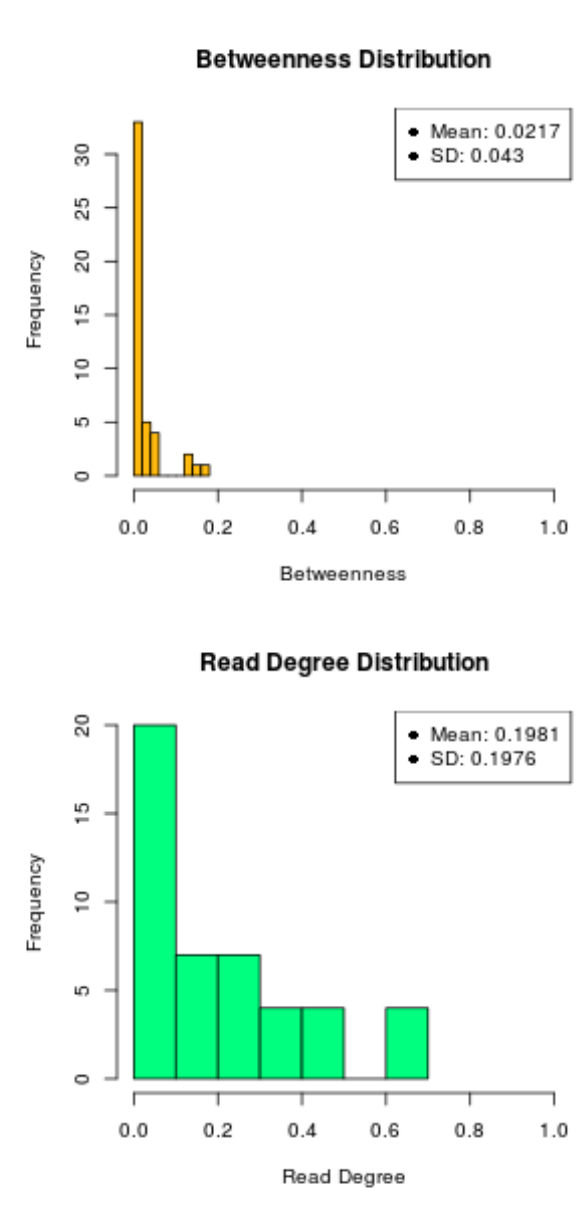
Figure 6. The distribution and summary statistics for the centrality